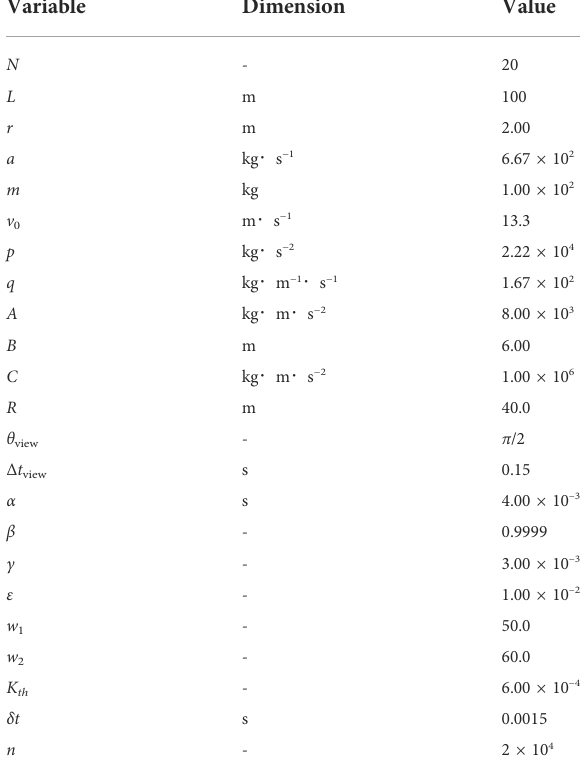
TABLE 1 Parameter values used in the